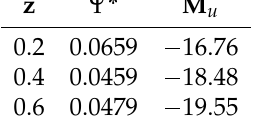
Table 4. Upper magnitude, M u (mag), and normalization, Ψ (cid:6) Mpc (cid:1) 3 , dependence on z when c